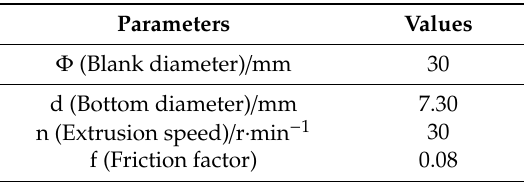
Table 1. Extrusion conditions of 45 # steel.